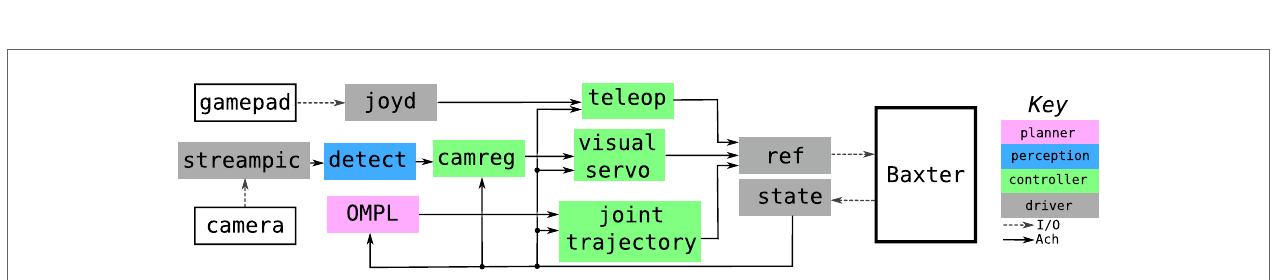
FigUre 4 | ach-based control system for the Baxter robot . Three control pipelines run concurrently: a teleoperation pipeline for manual control (top), a camera registration and visual servoing pipeline (middle, Dantam et al., 2016), and a joint planning (Sucan et al., 2012) and interpolation pipeline (bottom). The ref process multiplexes the output of these three pipelines and selects the highest priority command to send to the robot. A non-real-time logging process (not shown) also receives informational and error messages from the other control system processes over a single Ach channel and records the messages in a log file.